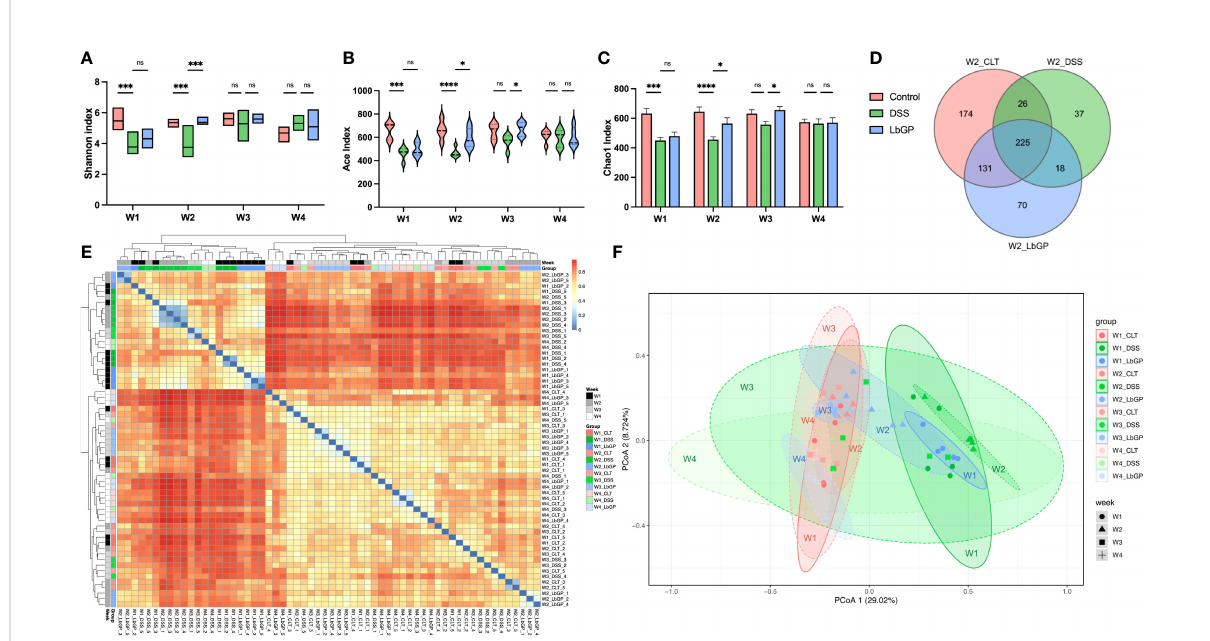
FIGURE 3 LbGP restored the gut microbial structure in mice with DSS-induced acute colitis. (A) Shannon index, (B) Ace index, and (C) Chao1 index among groups during 3 weeks. (D) Venn diagram of the OTU level at W2. (E) Heatmap of Bray-Curtis dissimilarity. (F) PCoA analysis of Bray-Curtis dissimilarity within PC1 and PC2 axes (n = 5, *P < 0.05, ***P < 0.0005, ****P < 0.0001). “ ns ” means ” no signi fi cant ”